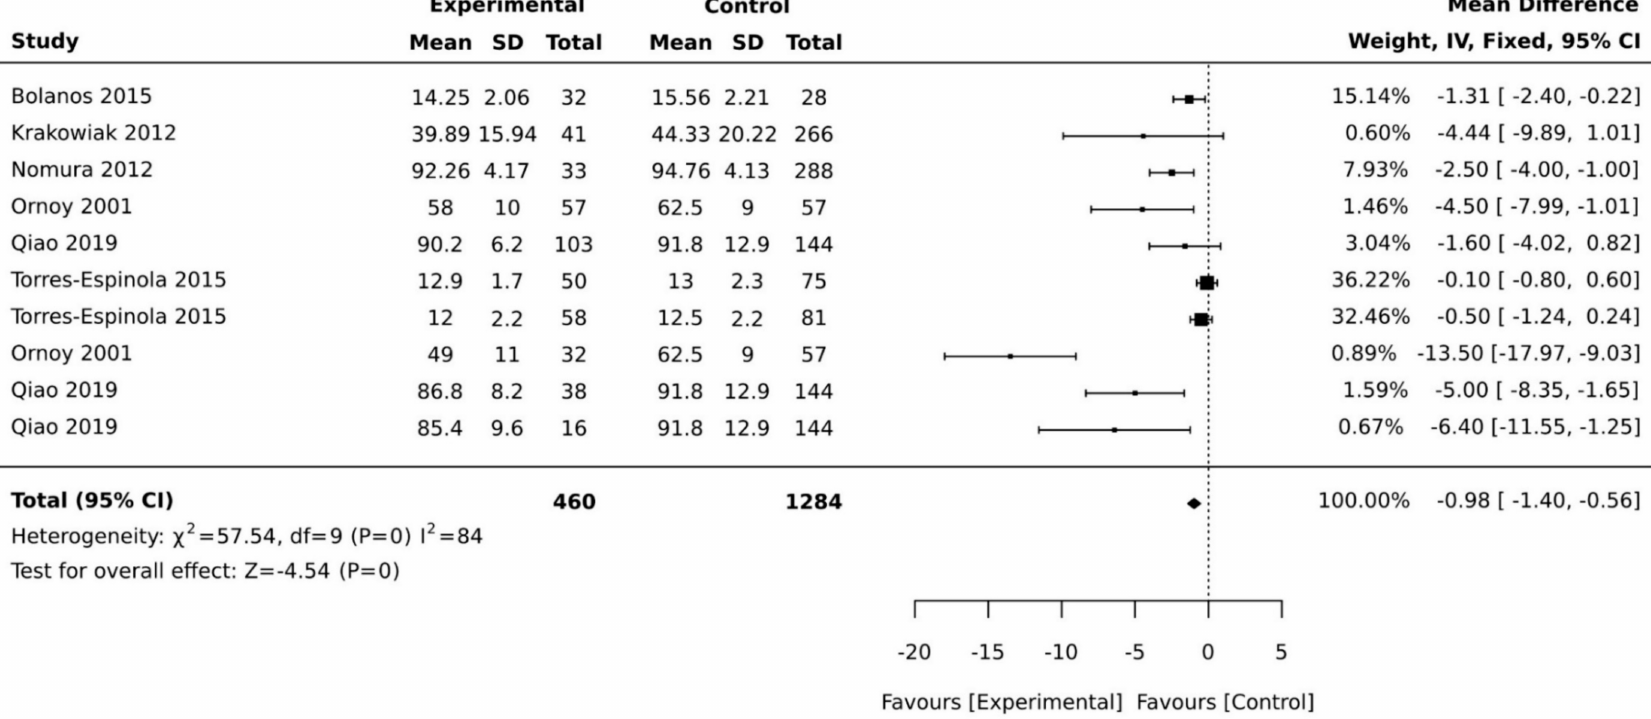
Figure 4. Forest plots comparing the differences in fine motor development between children born to mothers with and without maternal